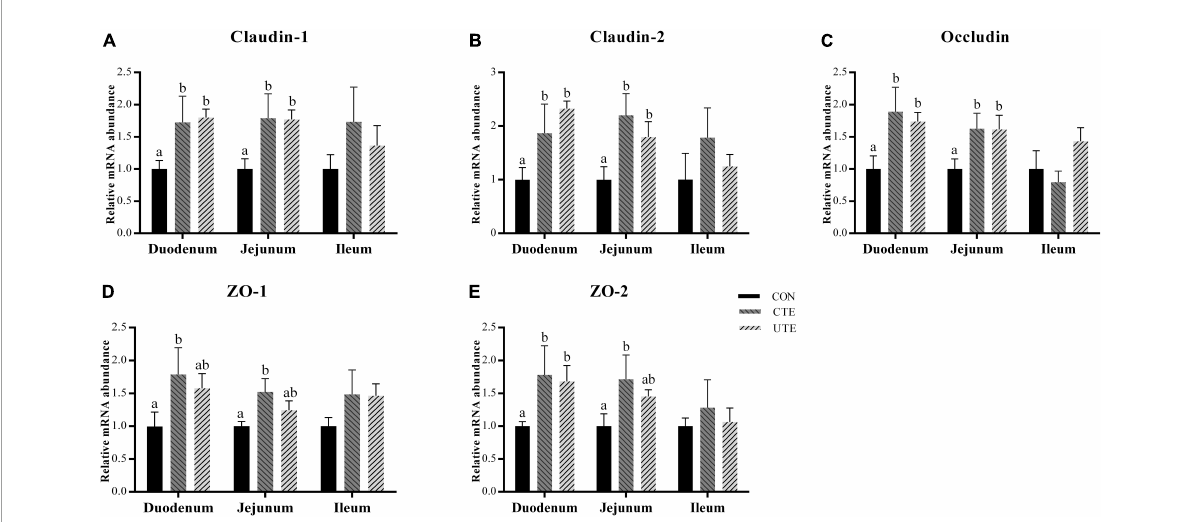
FIGURE2 Effects of coated and uncoated trace elements on the relative gene expression of Claudin-1 (A) , Claudin-2 (B) , Occludin (C) , ZO-1 (D) , and ZO-2 (E) in small intestine. CON, sheep fed with the basal diets; CTE, sheep fed with the basal diets plus 400 mg/kg coated trace elements; UTE, sheep fed with the basal diets plus an equal amount of trace elements in uncoated form. Data are represented as mean and standard error and with different small letter superscripts mean significantly different ( P < 0.05), n = 4.